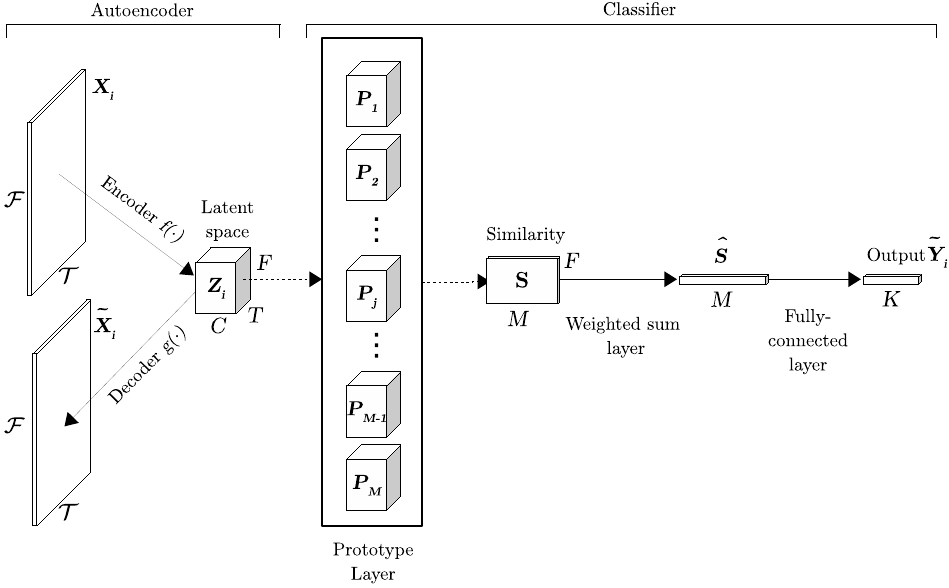
Figure 1. Diagram of the proposed model. Continuous arrows represent layers or sub-networks and they have the name below or to the left of them. Dashed line arrows represent unit